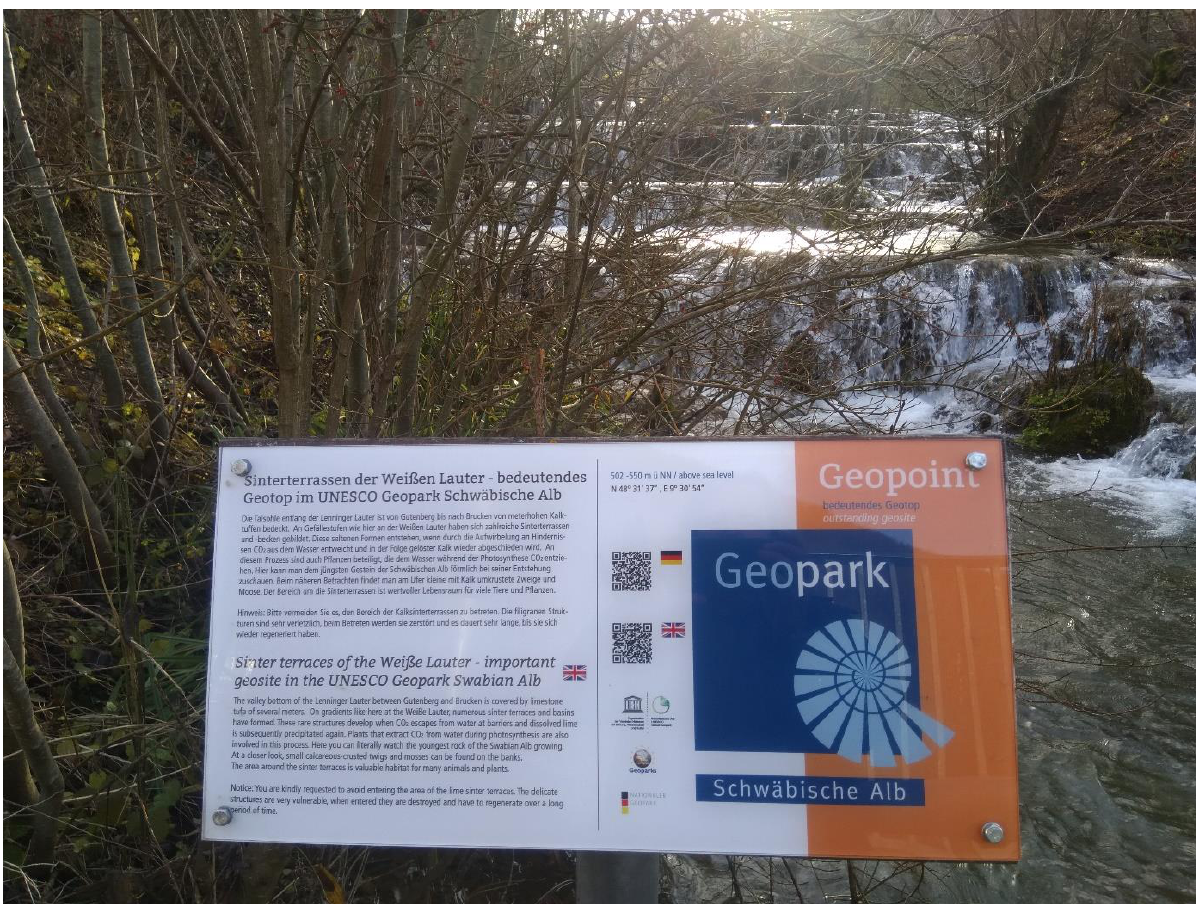
Figure 6. Geopoint Swabian Alb (Copyright: Megerle 2020).